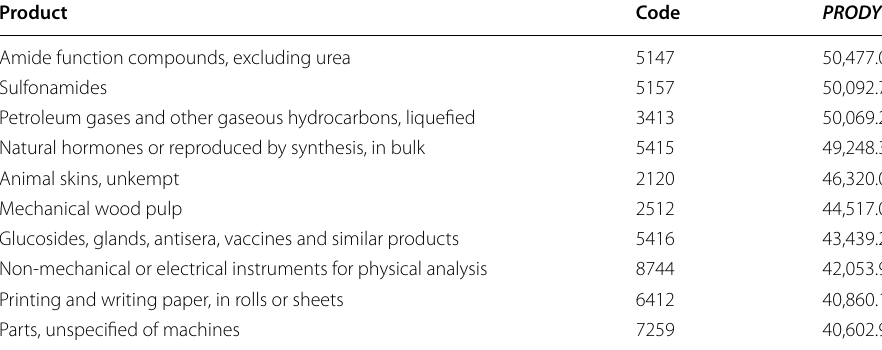
Table 4 Ten most sophisticated products. Source : Author’s calculations